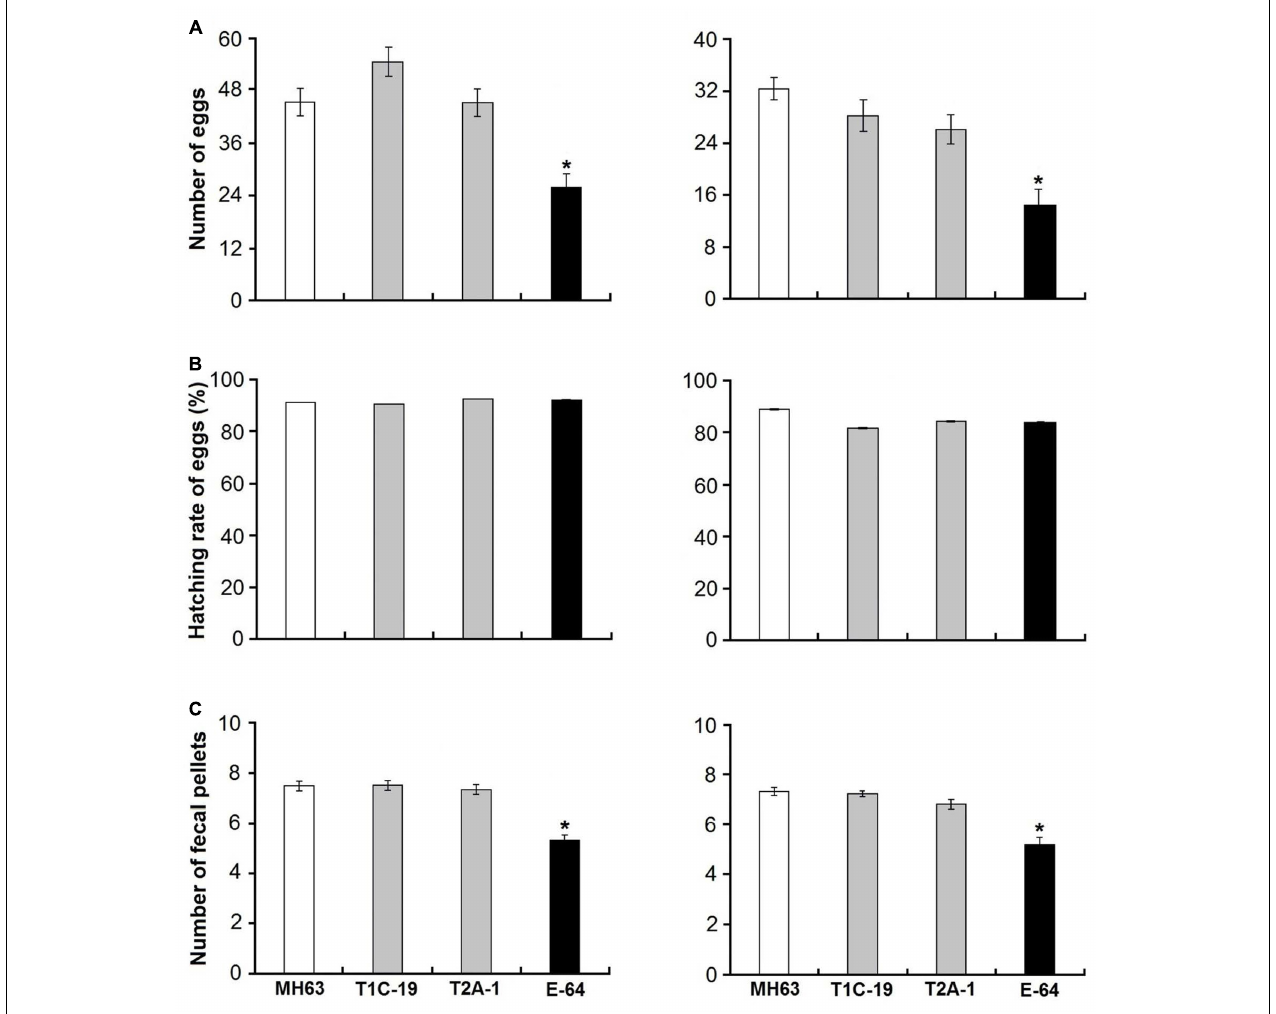
FIGURE 2 | Fecundity (numbers of eggs) produced per individual (A) , hatching rate of eggs (B) , and numbers of fecal pellets produced per individual (C) of F. candida fed on a diet consisting of rice pollen (left) or a mixture of rice leaf powder and baker’s yeast (10:1) (right). The rice pollen and rice leaf powder were obtained from either of two Bt rice lines (T1C-19: Cry1C and T2A-1: Cry2A) or their non- Bt near isoline MH63 (negative control). For the positive control, the corresponding non- Bt rice tissue was supplemented with E-64 (positive control) for 35 days. Values are means ± SE, n = 50. Asterisks indicate a significant difference between the treatment and the negative control (MH63) (Dunnett’s test, P < 0.05).